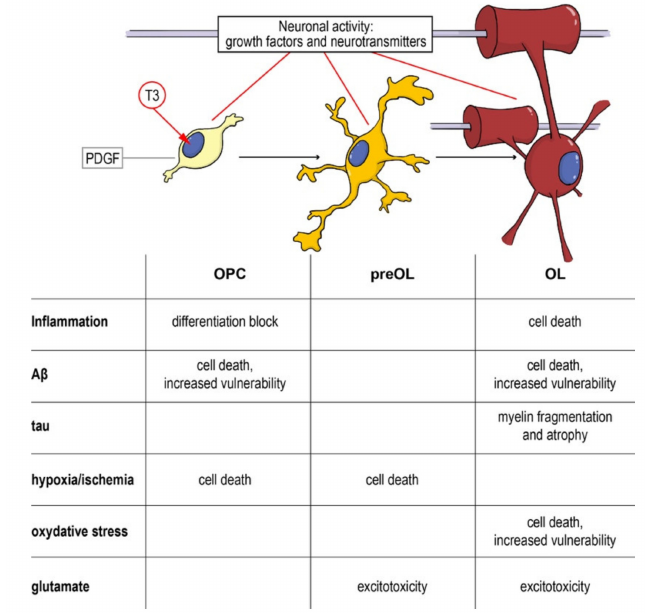
Figure 4. From the precursor to the mature oligodendrocyte: impact of noxious stimuli on di ff erentiation and viability. Schematic representation of the physiological di ff erentiation from the oligodendrocyte precursor cell (OPC) to myelinating OL. T3, the active form of the thyroid hormone, is the trigger of the process, drivingthecelloutofthecellcycleandstartingthedi ff erentiationmachinery. Neurotransmitters (such as GABA, glutamate and NO) directly contribute to regulating the process and the interaction between the axon and its activity and the OPCs / OLs. In the table are summarized the di ff erent component of neurodegenerative and demyelinating diseases a ff ecting the di ff erent di ff erentiation stages. Abbreviations: A β , amyloid beta; OL, oligodendrocyte; OPC, oligodendrocyte precursor cell; PDGF, platelet derived growth factor; T3,